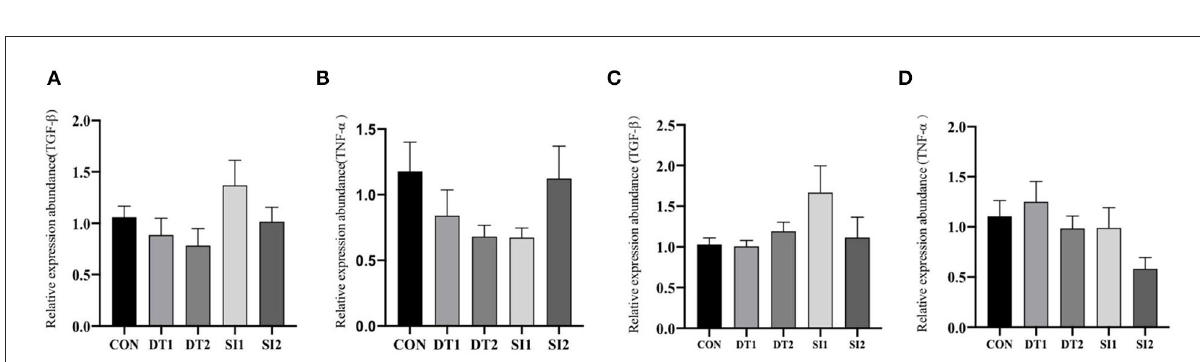
FIGURE3 Effects of dietary dandelion or soybean isoflavones on the messenger RNA (mRNA) expression of inflammation-related genes in duodenum (A, B) and ileum (C, D) .